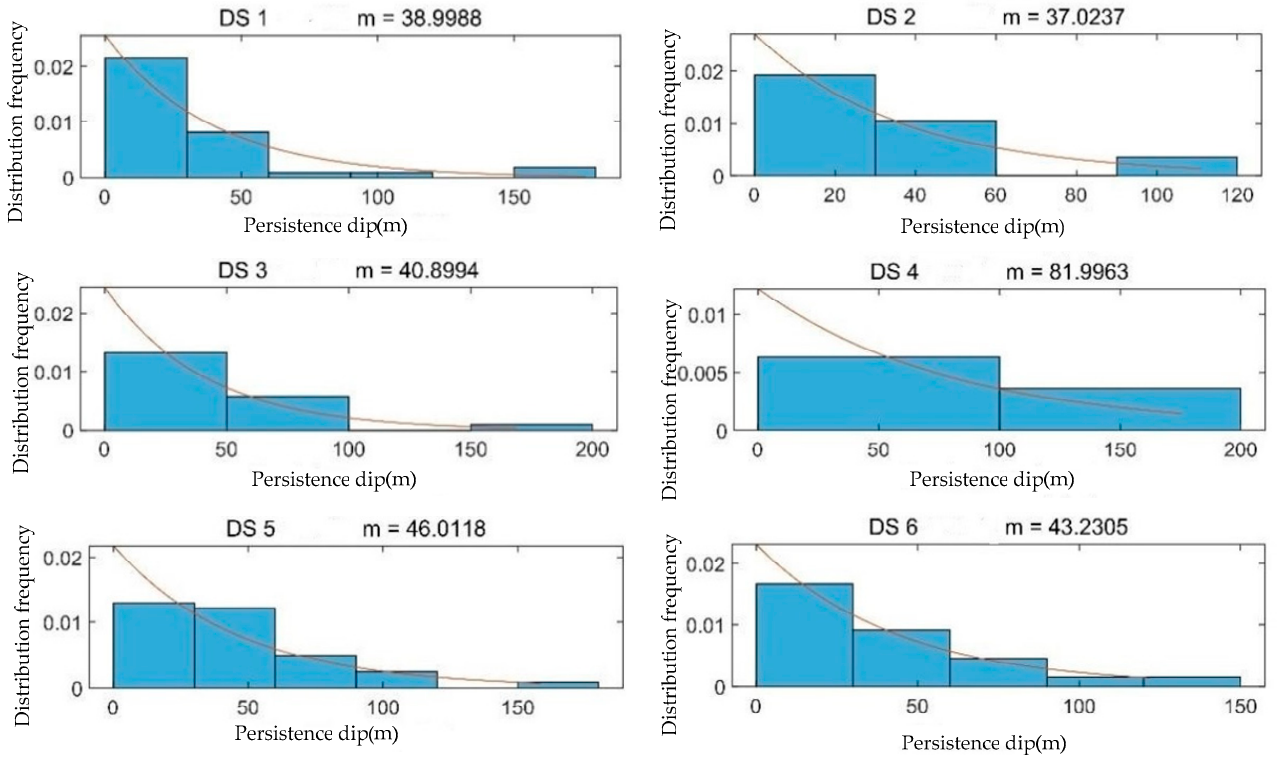
Figure 18. Histogram of cliff wall continuity.